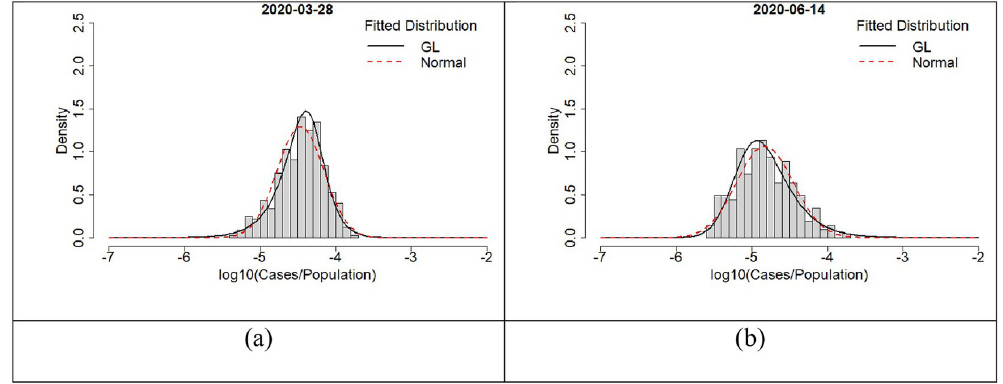
Fig 2. Histograms of per capita cases in English and Welsh LTLAs. Some periods within the time series showed negative skew (a) while others were positively skewed (b).